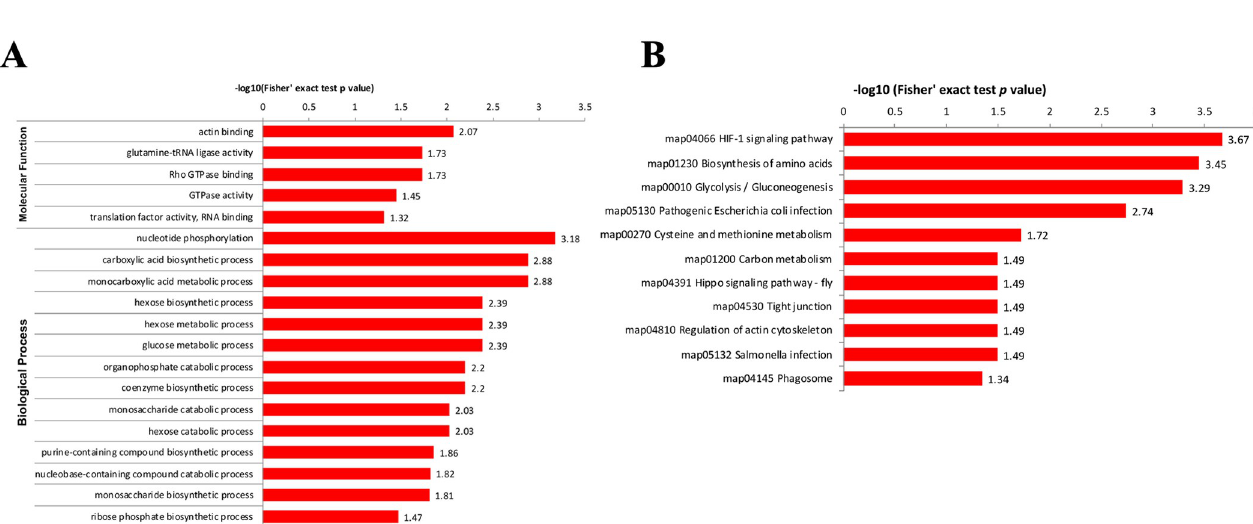
PLOS NeglectedTropical Diseases | https://doi.org/10.1371/journal.pntd.0010431 May 16,